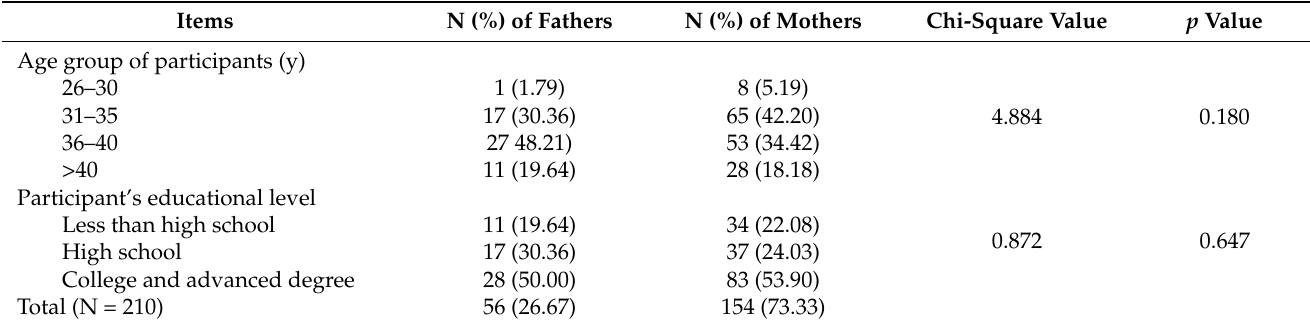
Table 1. The characteristics of parents with children affected by